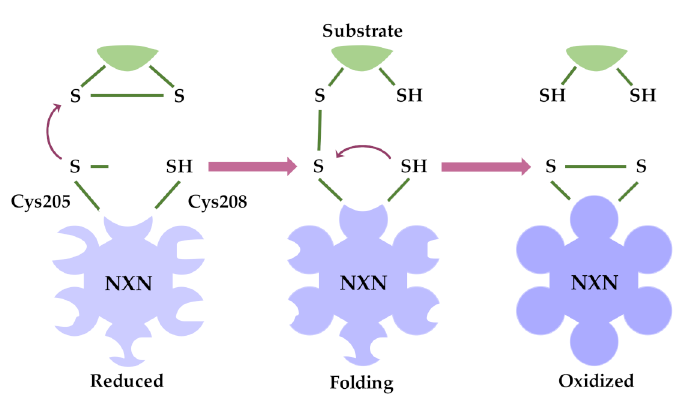
Figure 2. Oxidoreductase activity of NXN. Based on the function of a conventional, the image shows a hypothetical function of NXN. A nucleophilic attack by the NXN Cys residue to one of the Cys residues of substrate protein initiates the reaction. NXN and the substrate protein are linked by the disulfide bond as an intermediate reaction. Then, NXN Cys208 residue attacks Cys205 residue, and the reaction ends with an oxidized NXN containing a disulfide bond, as well as, a reduced substrate protein. This mechanism might modify the conformation of NXN; however, it has been not described yet. Modified/adapted from Funato Y. and Miki H. (2007 and 2010)